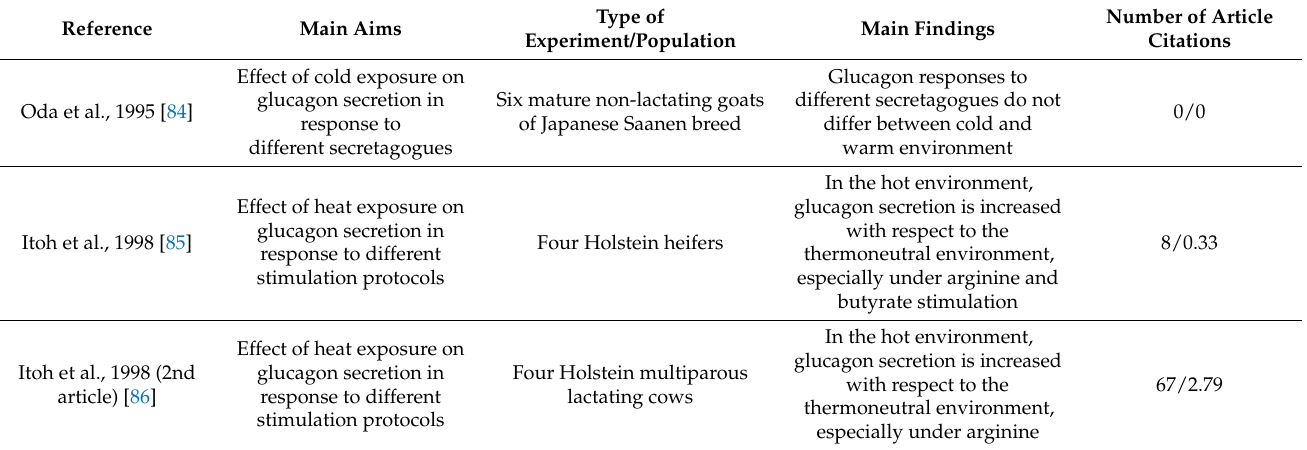
Figure 1. PRISMA flow diagram of the literature search strategy. Table 3. Summary information related to the studies concerning the effects on the alpha cell of physical environmental factors (heat or cold exposure). The number of citations (total/per year) is from SCOPUS (last checked: 30 September